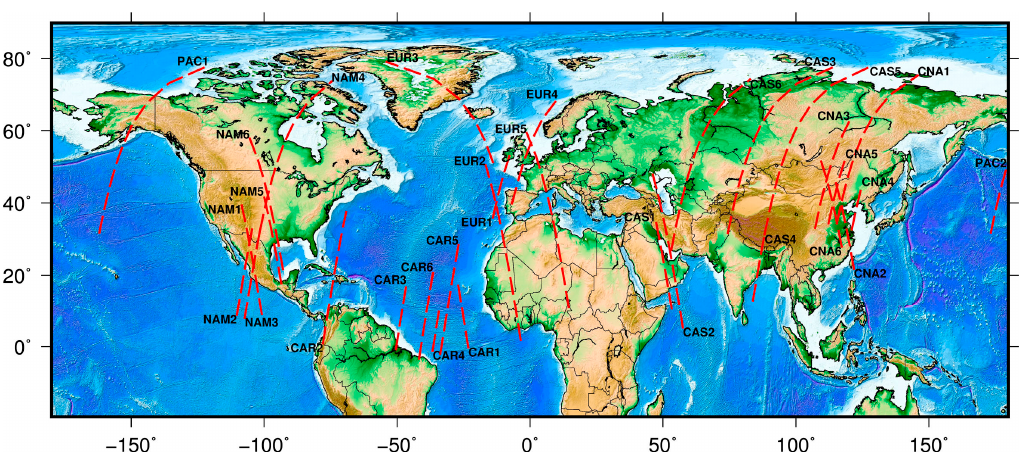
Figure 2. List of CALIPSO passes used in this study (with topographic background); all the comparisons with CHIMERE are provided in Supplementary Materials (Figures S1–S5). Dates of passes and approximate hour (YYYYMMDD HH:MM UTC) for each cases: CAR1: 20140305 15:00; CAR2: